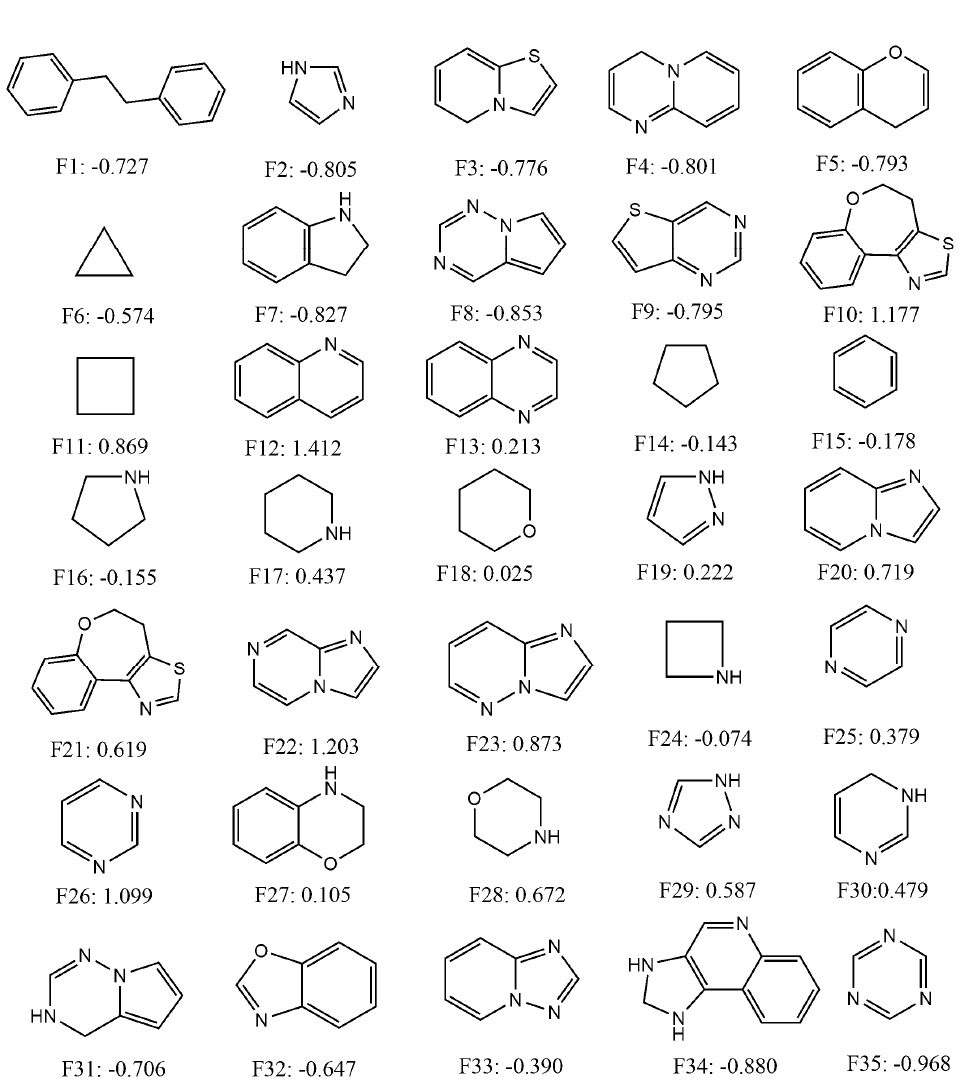
Figure 3. Chemical structures and average standardized scores of selected fragments.